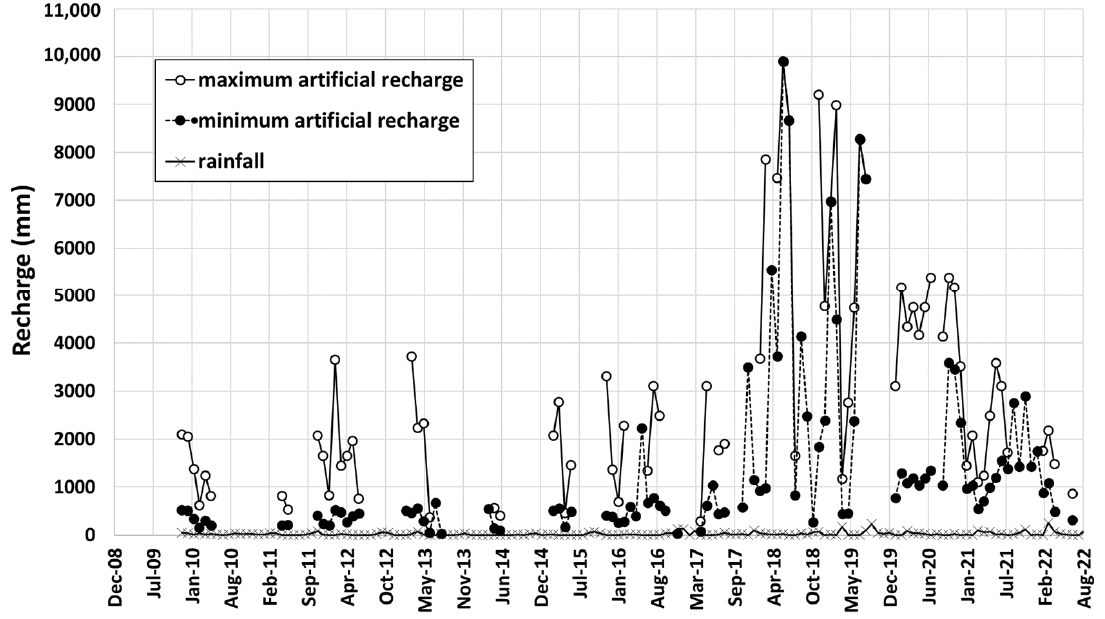
Figure 3. Maximum and minimum recharge on the salt marsh together with rainfall.